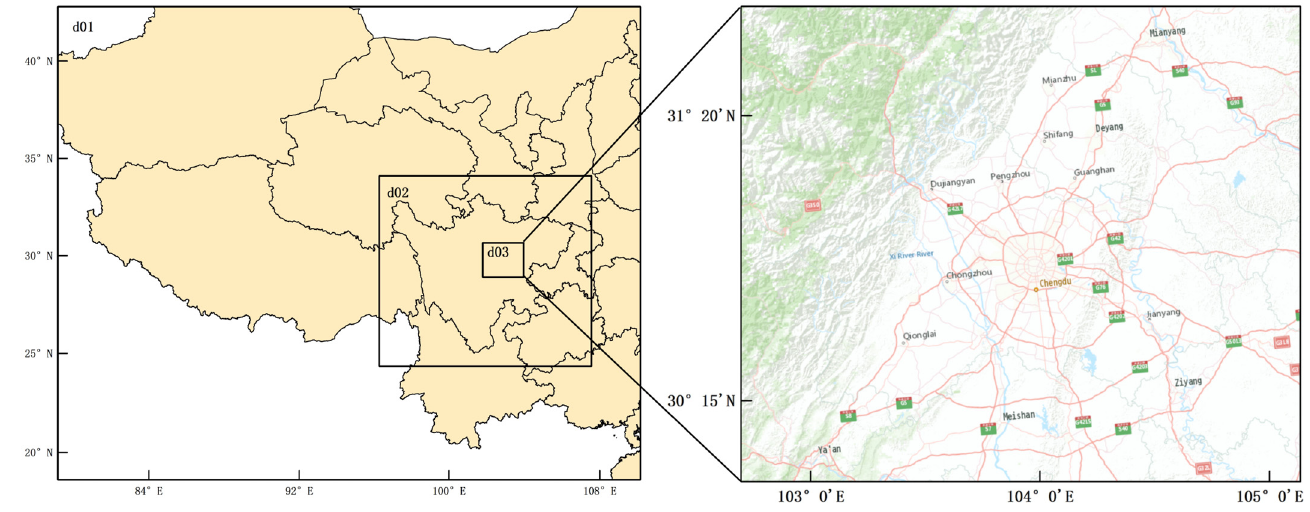
Figure 1. Three-level nested modeling domains.